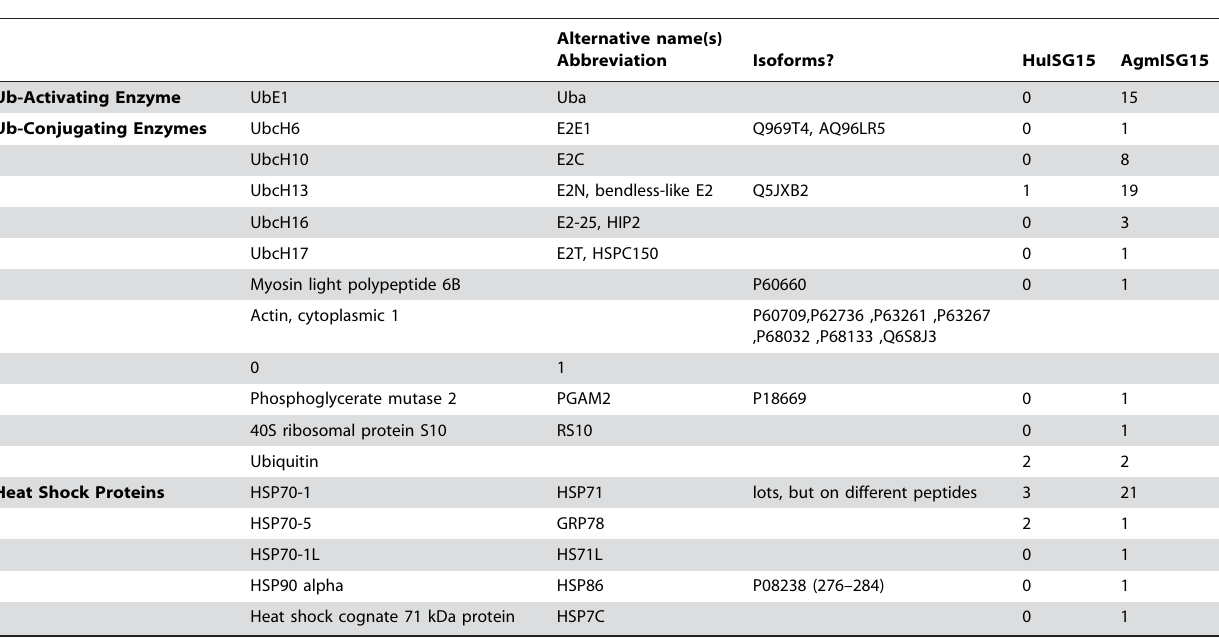
Table 2. ISGylated targets identified by TAP purification and LC-MS/MS identification of AgmISG15 outnumber those of HuISG15.